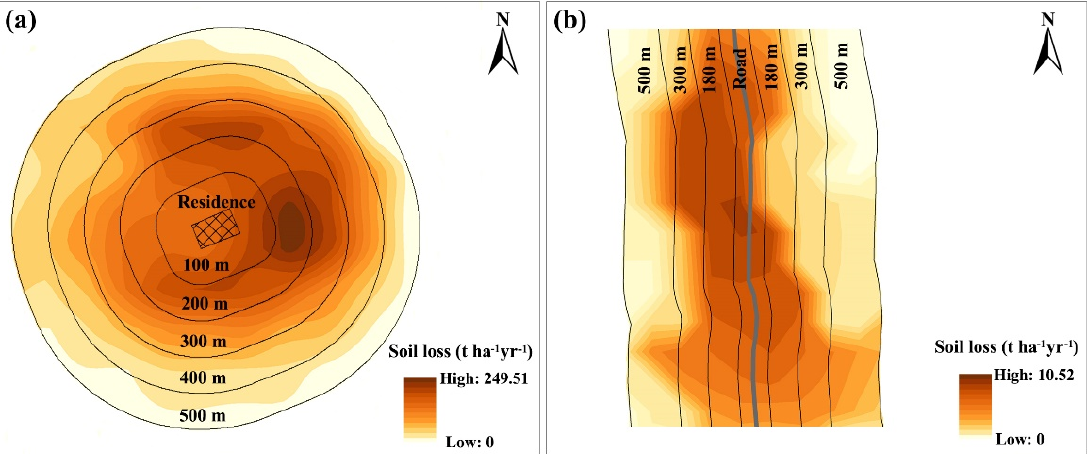
Figure 3. Cases of the spatial distribution of wind soil loss in typical residence (a) and road (b) buffer zones.